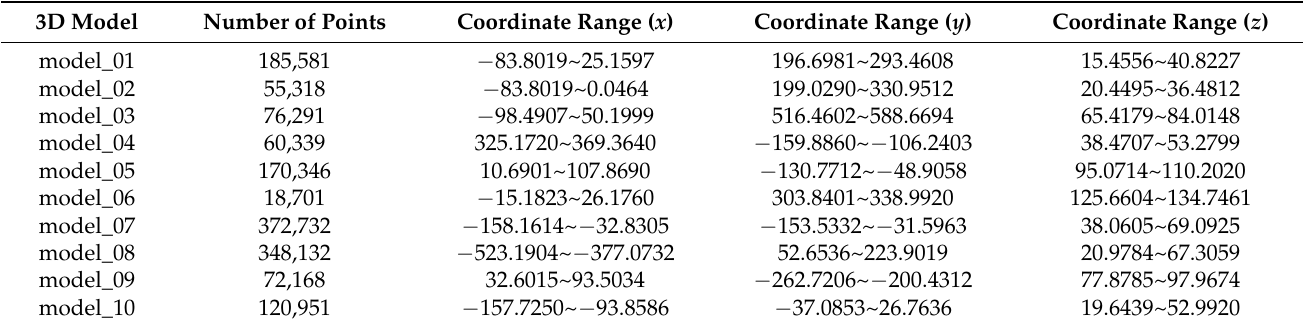
Table 1. Properties of the experimental 3D